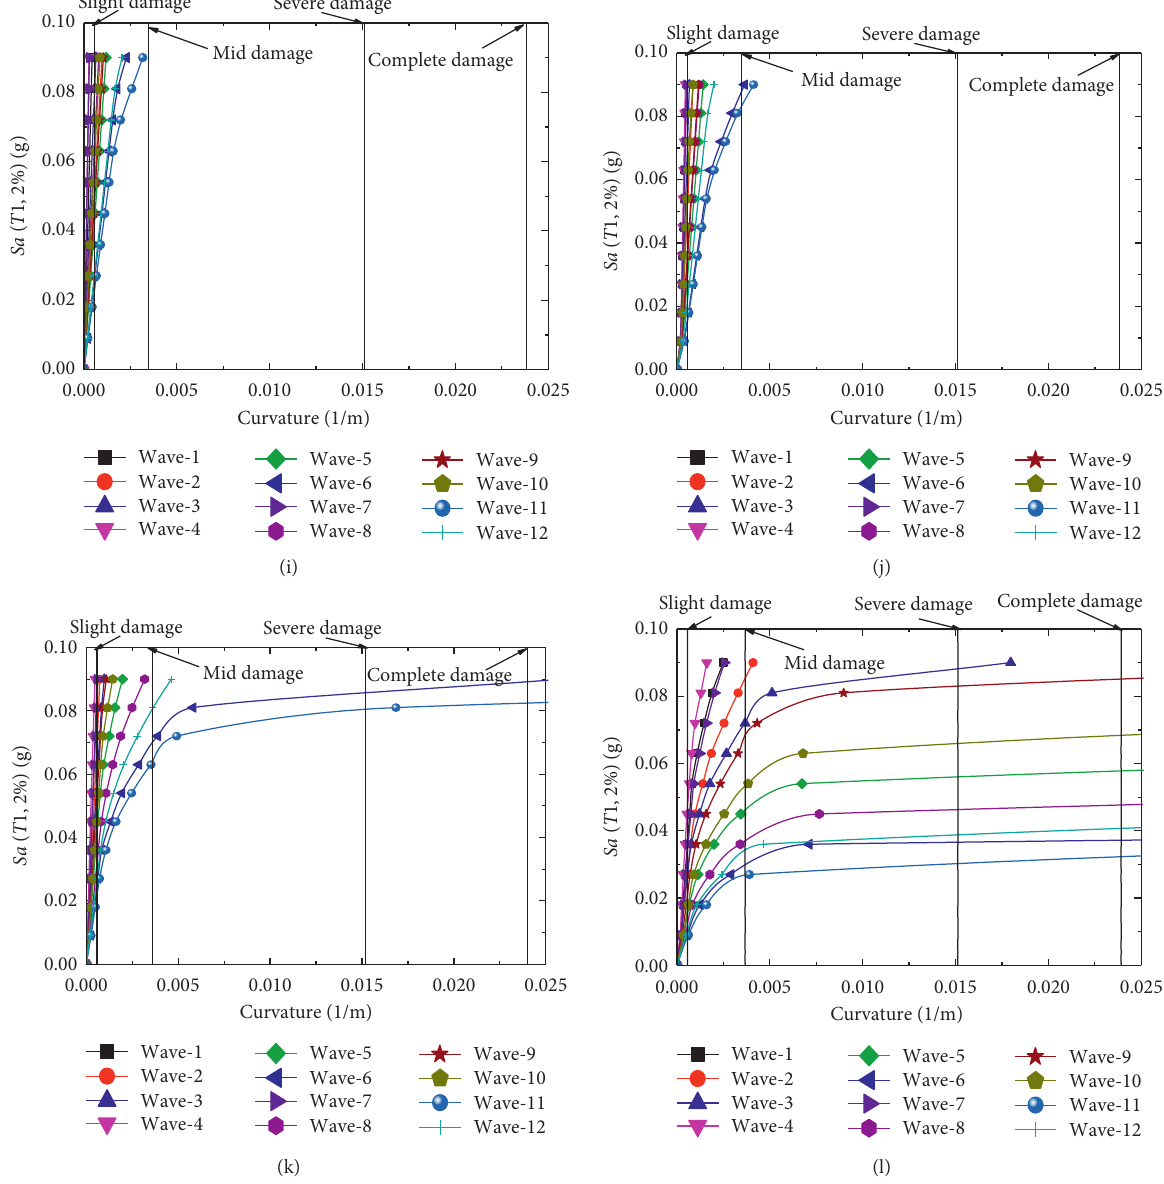
Figure 5: The IDA curve of the Puli Bridge. (a) Section L-A. (b) Section R-A. (c) Section L-B. (d) Section R-B. (e) Section L-C. (f) Section R-C. (g) Section L-D. (h) Section R-D. (i) Section L-E. (j) Section R-E. (k) Section L-F. (l) Section